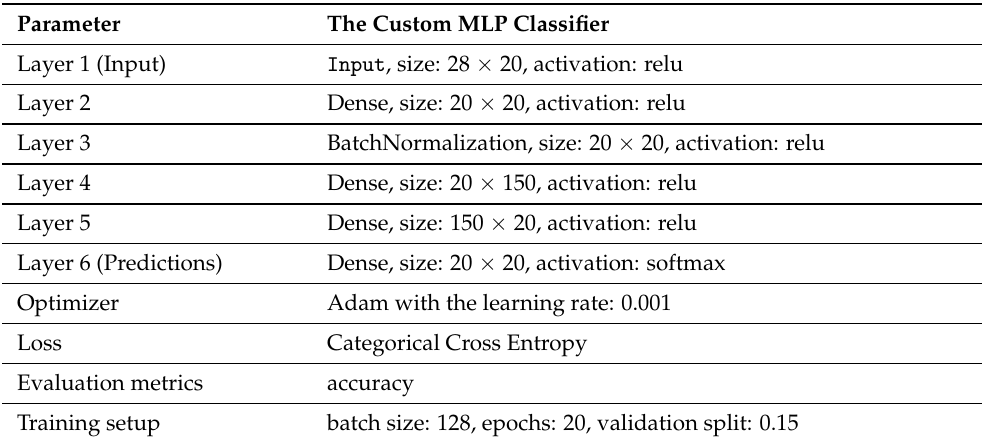
Table 6. Custom MLP classifier architecture setup per each layer (6) with selected optimizer, loss function, evaluation metric, and training